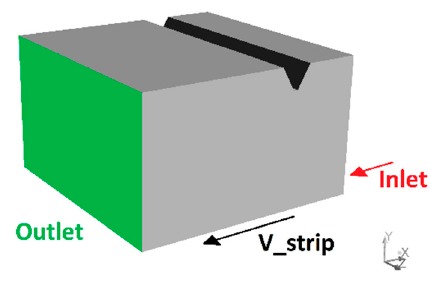
Figure 3. Outlet and inlet of the flow in the simulation domain.